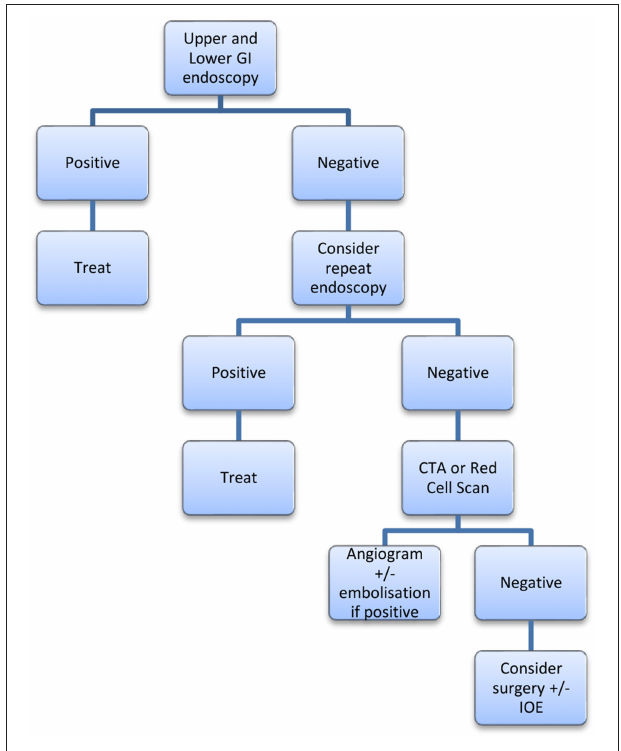
FIGURE 2 | Proposed algorithm for Overt GI